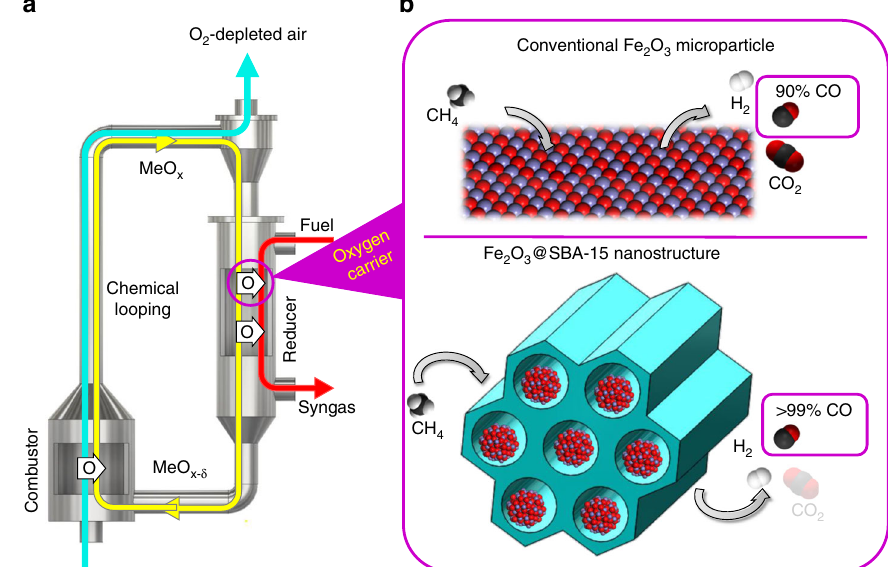
Fig. 1 Chemical looping partial oxidation with methane. a Schematic of the chemical looping partial oxidation process; b structure and CO selectivity in conventional oxygen carrier vs Fe 2 O 3 @SBA-15 oxygen